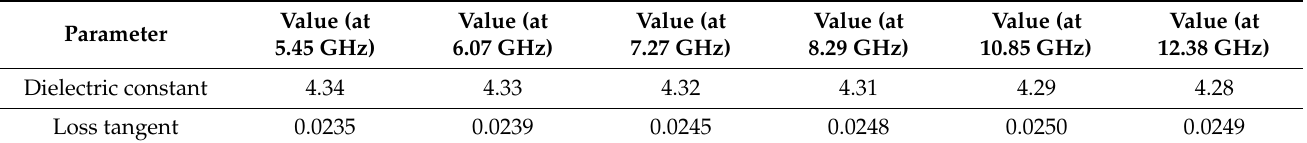
Table 3. Dielectric constant and loss tangent at various frequencies. Value (at Parameter